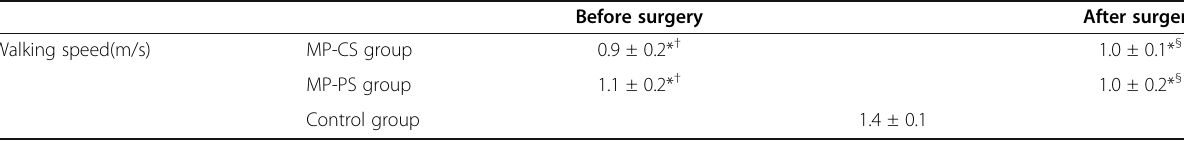
Before surgery After surgery